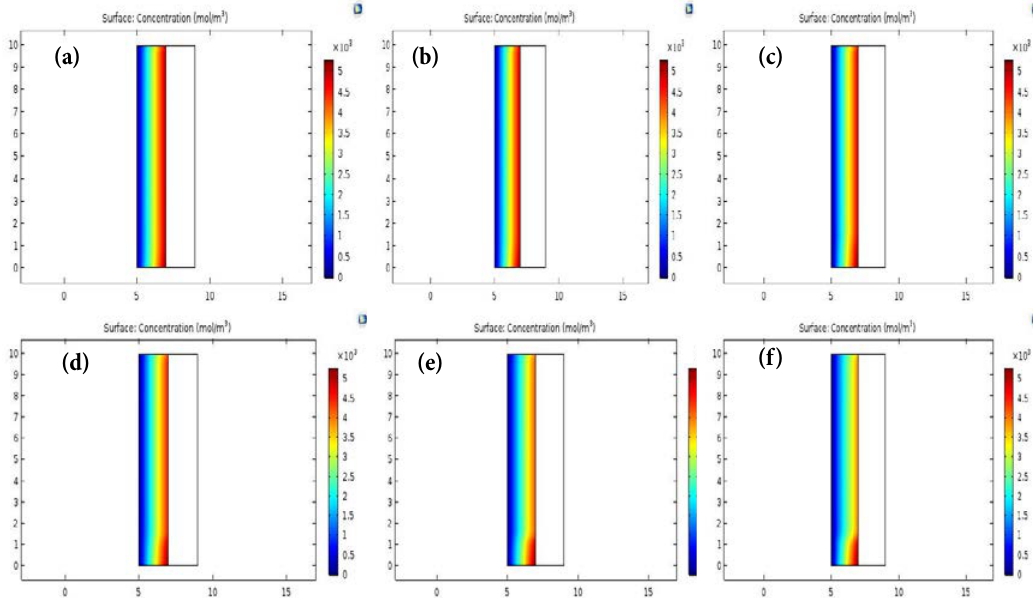
Fig. 14: Concentration distribution of water in membrane phase at different separation times (0.5 l/min flow rate and 30°C temperature); (a) 1min, (b) 2min, (c) 5min, (d) 10min, (e) 20min and (f) 30min